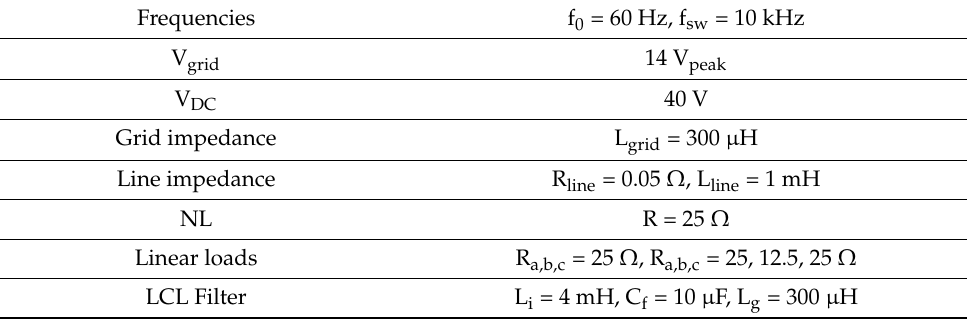
Figure 6. Experimental setup of the system. Table 1. System parameters.